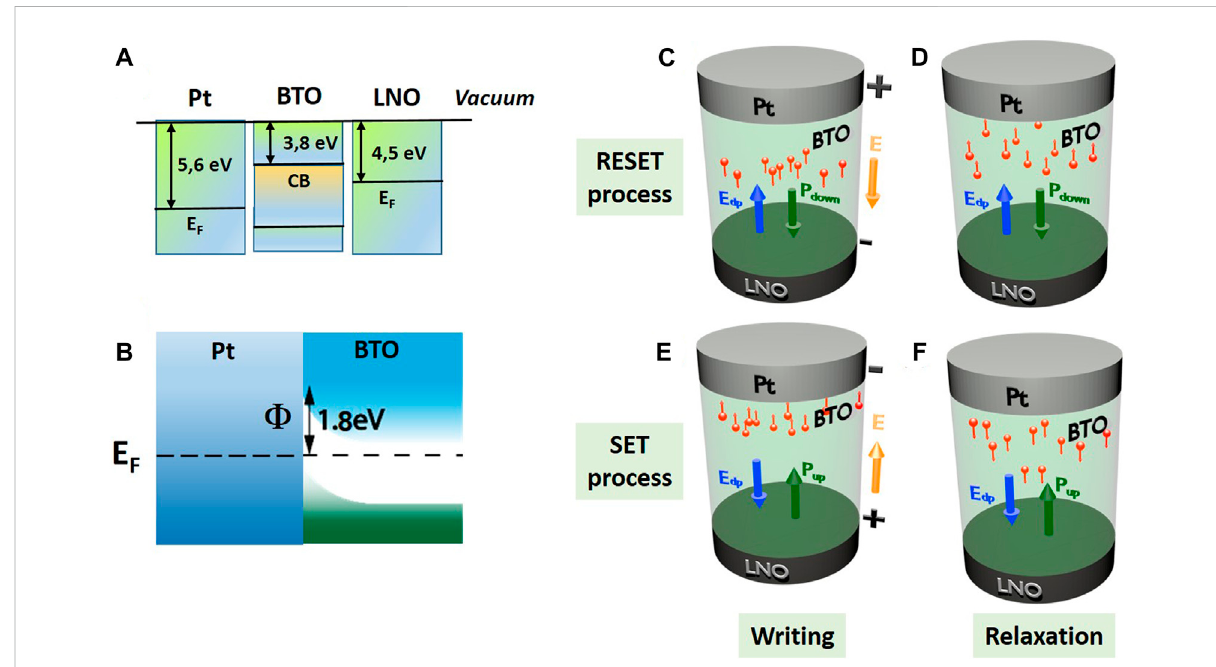
FIGURE 6 (A) Sketch with a comparison of the main features of the band structures of Pt, BaTiO 3 (BTO) and LaNiO 3 (LNO). The work functions of the metals and the electron af fi nity of BaTiO 3 (all in eV) are indicated. E F and CB refer to the metals Fermi levels and the bottom of the BTO conduction band, respectively; (B) Band diagram corresponding to the Schottky Pt/BaTiO 3 interface. The barrier height Φ ≈ 1.8 eV is indicated; (C – F) Sketch depicting thememristive mechanism ofourSi(001)/YSZ/CeO 2 /LaNiO 3 /BaTiO 3 /Ptdevices.ThetoprowillustratestheRESETprocessduringthe application of the external voltage (C) and the resistance relaxation in zero bias afterwards (D) . The directions of the external electrical fi eld, the ferroelectricpolarization and the depolarizing fi eld are indicated with yellow, greenand bluearrows, respectively. Oxygen vacancies are depicted as orange balls. The bottom row illustrates the SET process, both during the application of the external voltage (E) and the relaxation afterwards (F)